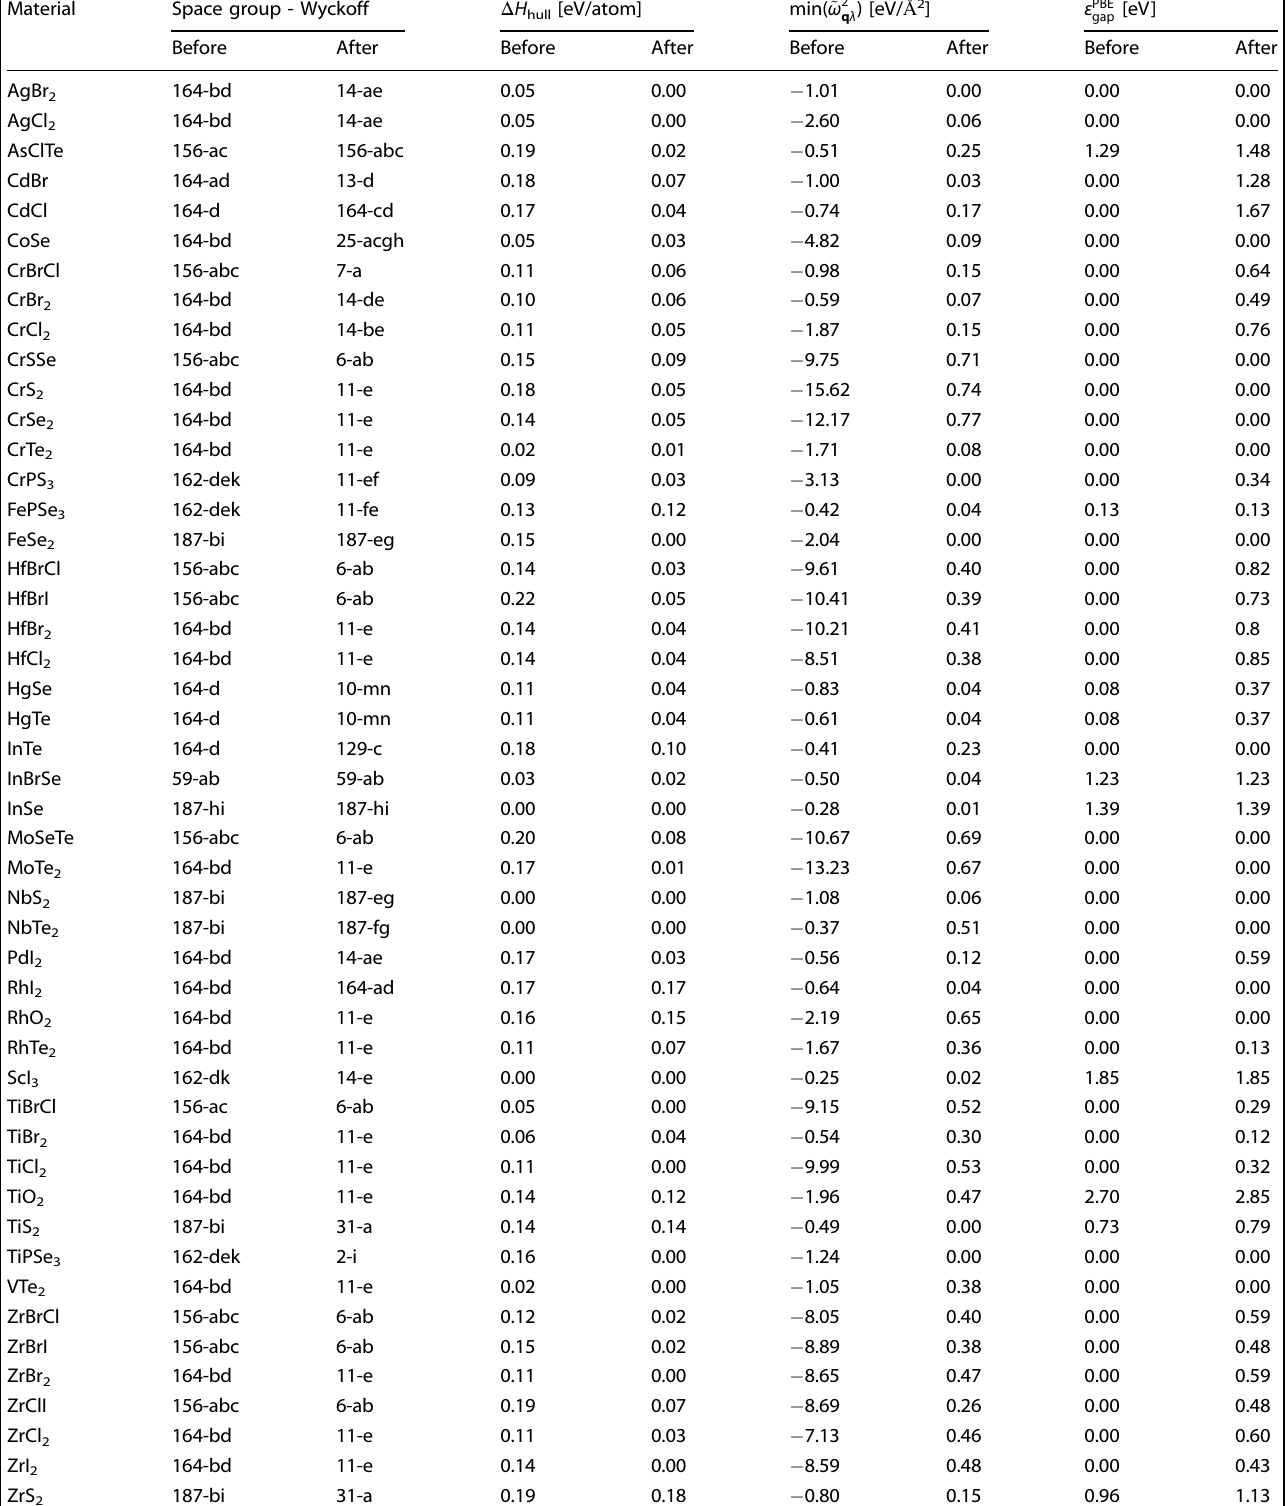
Table 1. Properties of the stable